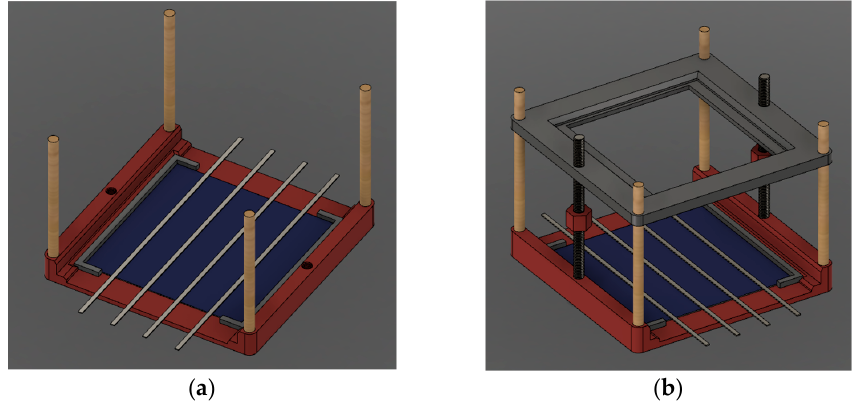
Figure 13. Modular platform designed for the measurement of I-V curves, electroluminescence, thermography, and other techniques. ( a ) Base with the cell and adapters. ( b ) With the addon for supporting the LED illumination board.